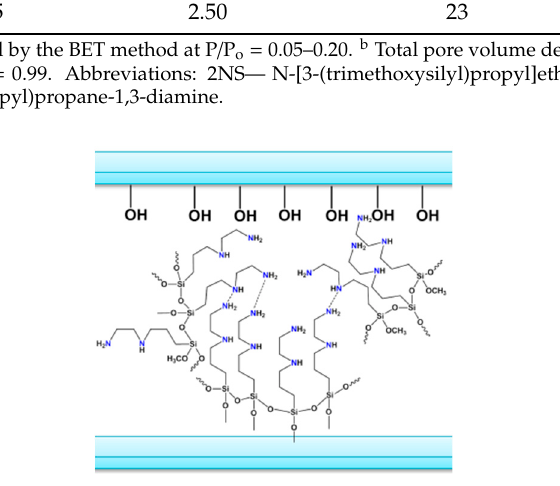
Figure 1. Amine functionalization inside the silica pores by the incipient wetness technique.